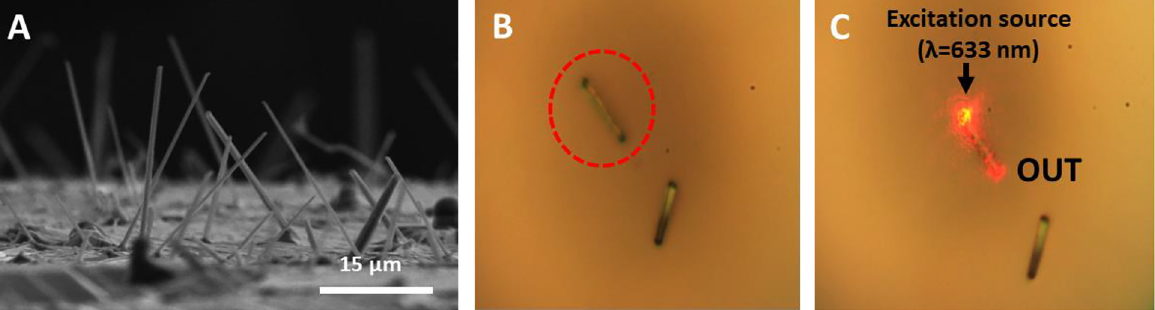
Figure6: (A)ScanningElectronMicroscope(SEM)imagefromNiO microwires fabricatedusingNi andSnO 2 inthestarting mixture.(B)Optical imagesfrom theNiOmicrowiresplacedontoa Sisubstrateand(C) bright fi eldimagefrom Ni:SnO 2 microwireshowingwaveguidingbehaviour under a red laser